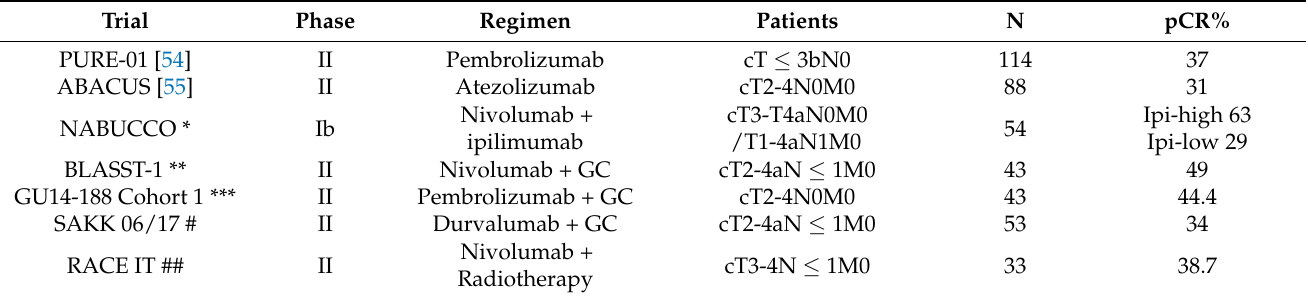
Table 2. Outcomes from Select Clinical Studies of neoadjuvant immunotherapy for